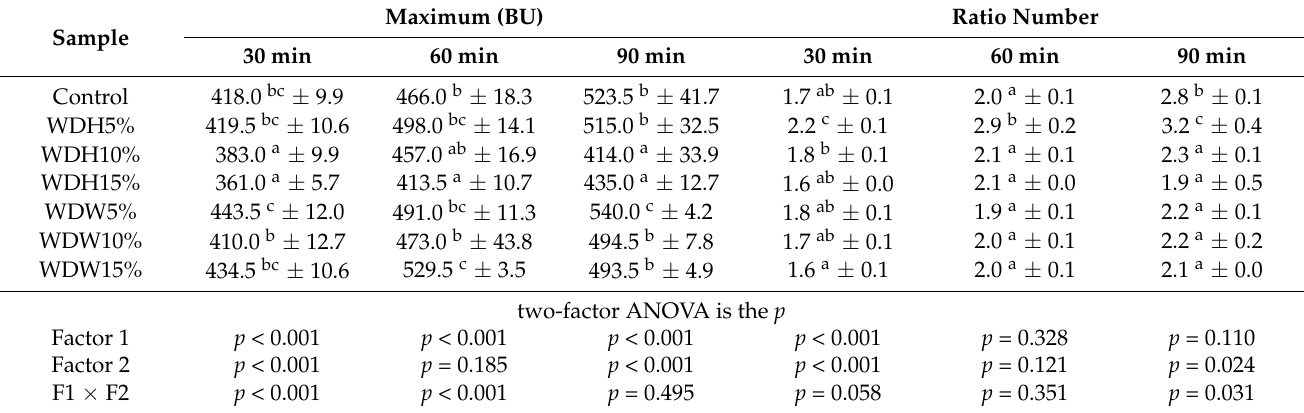
Table 3. Extensographic properties of the tested wheat doughs with the addition of nut